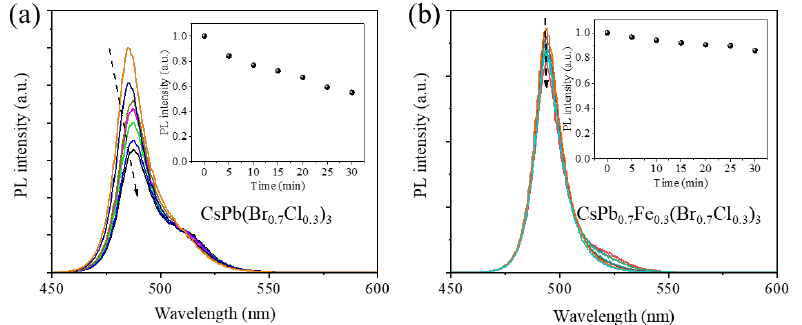
Figure 6. ( a ) PL spectra of CsPb(Br 1 − x Cl x ) 3 NCs under continuous UV irradiation. ( b ) PL spec-